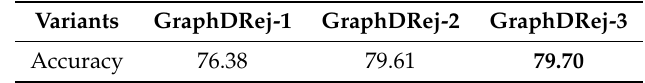
Table 6. The accuracy (%) for evaluation of GraphDRej with the same number of layers on